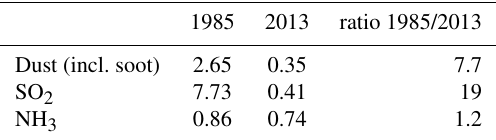
Table 2. Annual emissions of dust, sulfur dioxide, and ammonia for all of Germany for the years 1985 and 2013 in megatonnes, as provided by Umweltbundesamt (German Federal Environmental Agency, UBA, Kevin Hausmann, personal communication, 2017). So-called dust also includes, e.g., soot and resuspended material, aside from the natural mineral dust. The table also includes the fac- tors by which the concentrations in 2013 are scaled in order to esti- mate the concentrations for the mid-1980s